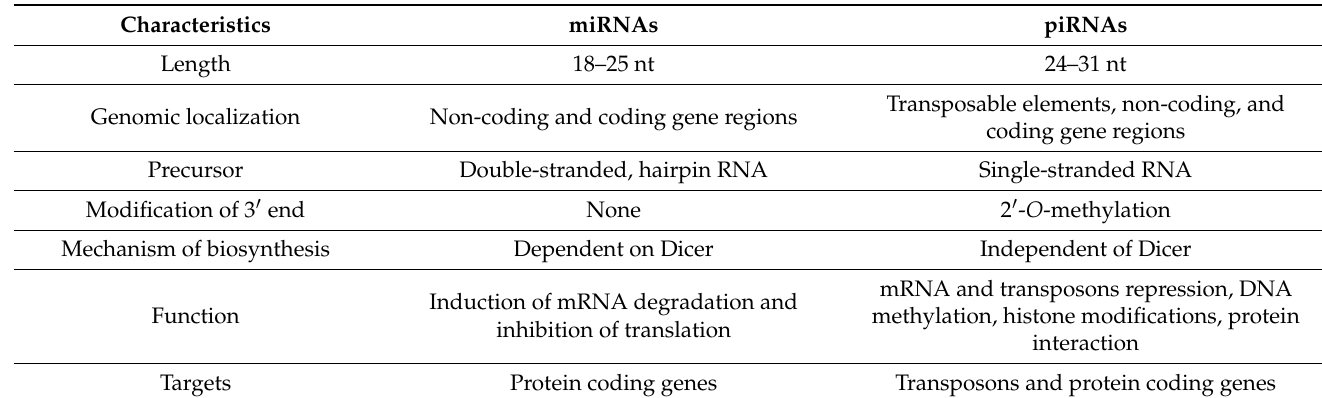
Table 1. Differences between miRNAs and